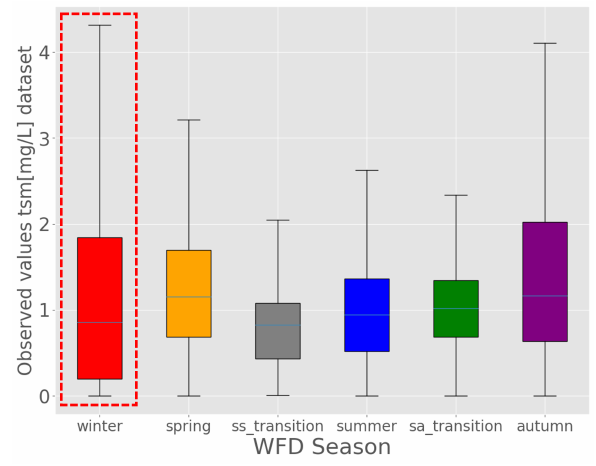
Figure 7. Boxplot per season- TSM (Lake Lugano).